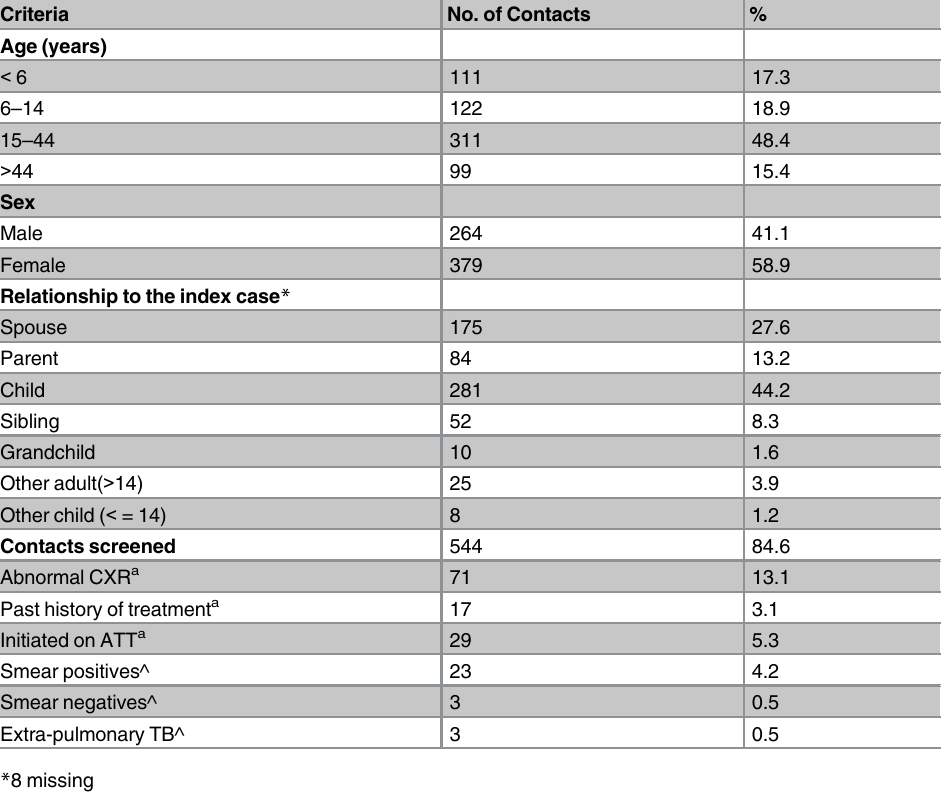
Table 2. Socio-demographic and clinical characteristics of house hold contacts of (N = 643) new spu- tum smear positive index cases in Chennai, India.